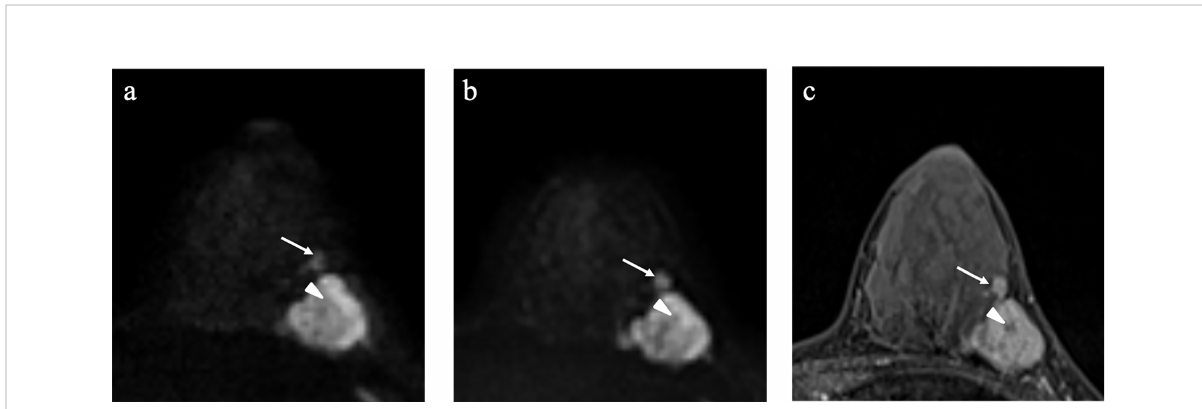
FIGURE 1 Example images of a 35-year-old woman with invasive ductal carcinoma in the left breast (A-C) . SMS-RS-EPI image of b 1,000 (A) ; advanced ZOOMit (A-ZOOMit) image of b 1,000 (B) ; dynamic contrast imaging of T1WI (C) . A-ZOOMit image showed a better image quality of the satellite nodule (long arrow) and necrosis (short arrow) than the SMS-RS-EPI